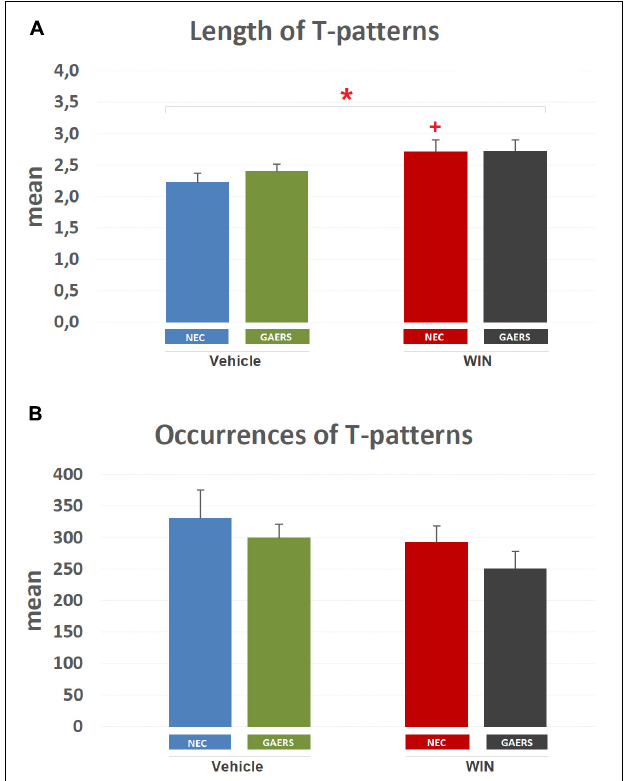
FIGURE 6 | Effect of WIN 55,212-2 and its vehicle on the length and occurrences of T-patterns in GAERS and NEC rats. Administration of WIN 55,212-2 (WIN; 2 mg/kg, IP) and its vehicle affected the mean length ± SEM (A) and mean occurrences ± SE (B) of T-patterns in each group detected during the 10 min of the hole-board test. * = significant ( p < 0.05) main effect of pharmacological treatment (Win vs. Vehicle, two-way ANOVA). Data were obtained from the analysis of four groups ( n = 15 subjects in each